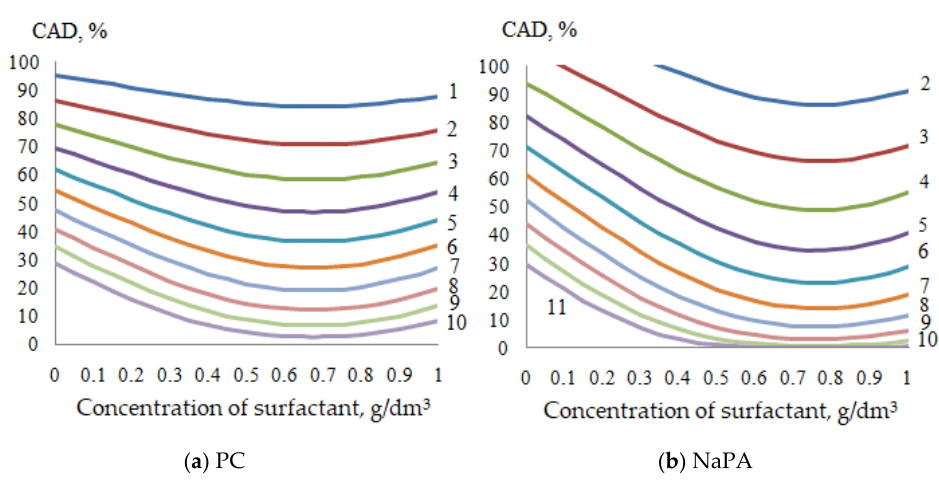
Figure 13. Lines of fixed average particle diameter of pigment depending on the content of the film-forming agent and the concentration of surfactants. APDP, microns: 1 — 1.0; 2 — 1.5; 3 — 2.0; 4 — 2.5; 5 — 3.0; 6 — 3.5; 7 — 4.0; 8 — 4.5; 9 — 5.0; 10 — 5.5; 11 — 6.0.